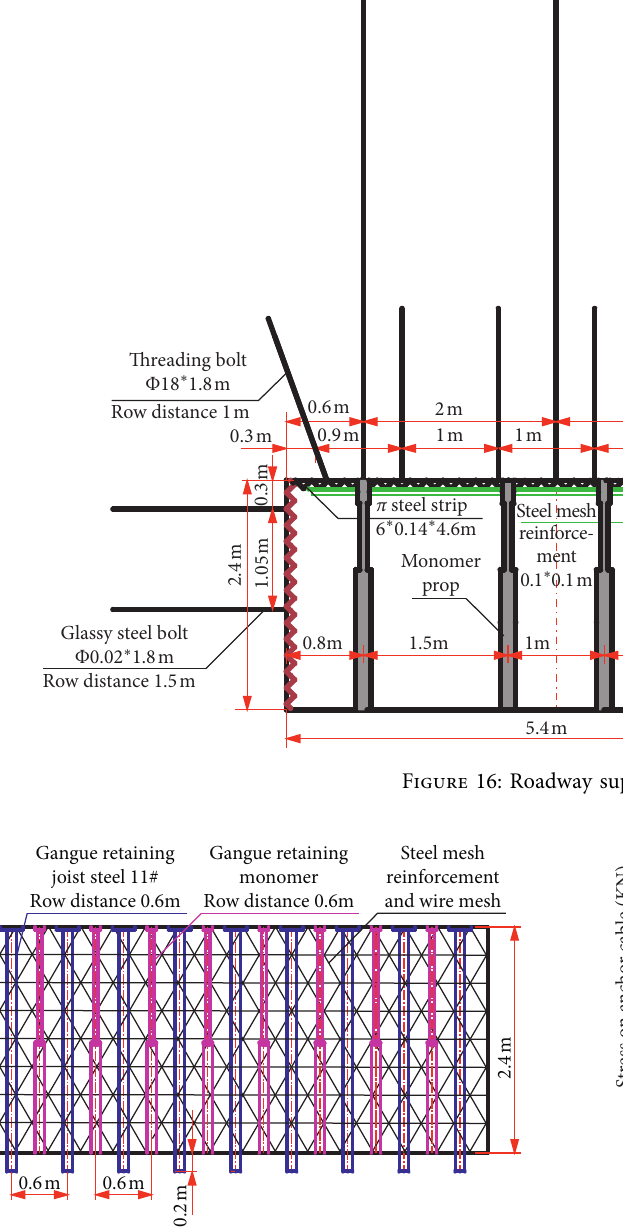
18: Stress curves of anchor